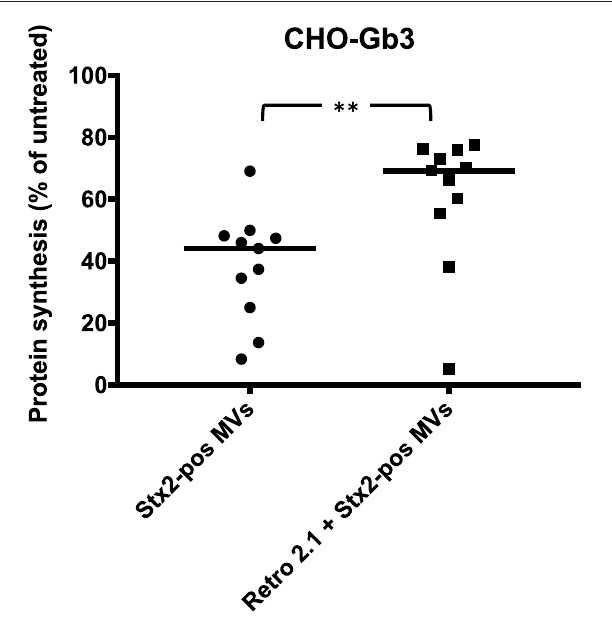
FIGURE 3 | Shiga toxin 2 delivered by microvesicles utilizes the intracellular retrograde pathway. The intracellular pathway of Shiga toxin 2-positive microvesicles (Stx2-pos MVs) was determined using Retro-2.1. CHO-Gb3 cells were treated with Retro-2.1 or PBS before addition of Stx2-positive microvesicles (Stx2-pos MVs) ( n = 11). A significantly higher protein synthesis was observed in CHO-Gb3 cells treated with Retro-2.1 compared to cells without pretreatment (median 69.3 and 44.1%, respectively, compared to untreated cells, defined as 100%). Median protein synthesis per cell is denoted by the bar. ** P < 0.01, Two-tailed Mann-Whitney U -test. Two independent experiments are